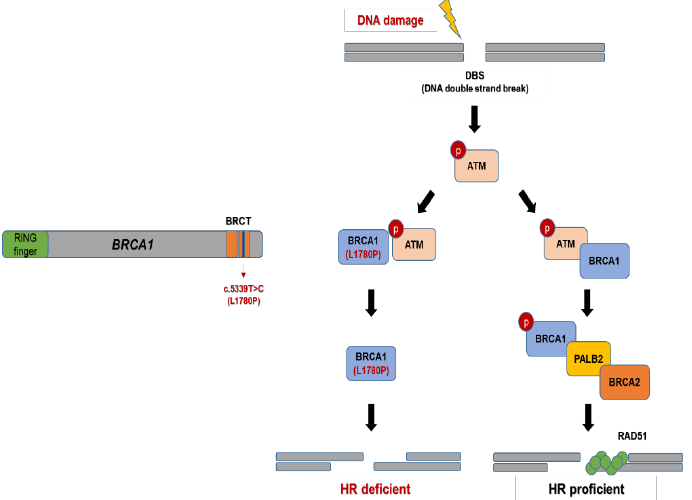
Figure 8. HR pathway in BRCA1 L1780P mutated TNBC cells. When DSB occurs, BRCA1 L1780P mutation affects the binding affinity between p-ATM and BRCA1. Therefore, RAD51 recruitment is